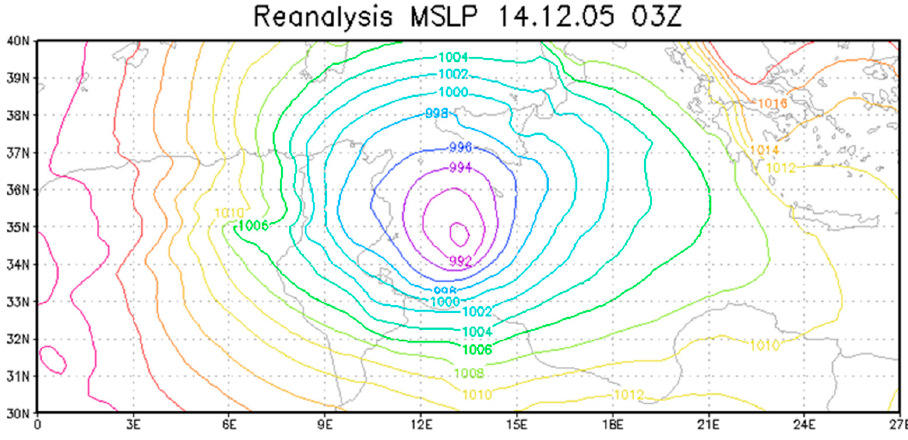
Figure 3. MSLP on 14 December 2005 03:00 UTC (time of lowest MSLP) from ERA5 [20].